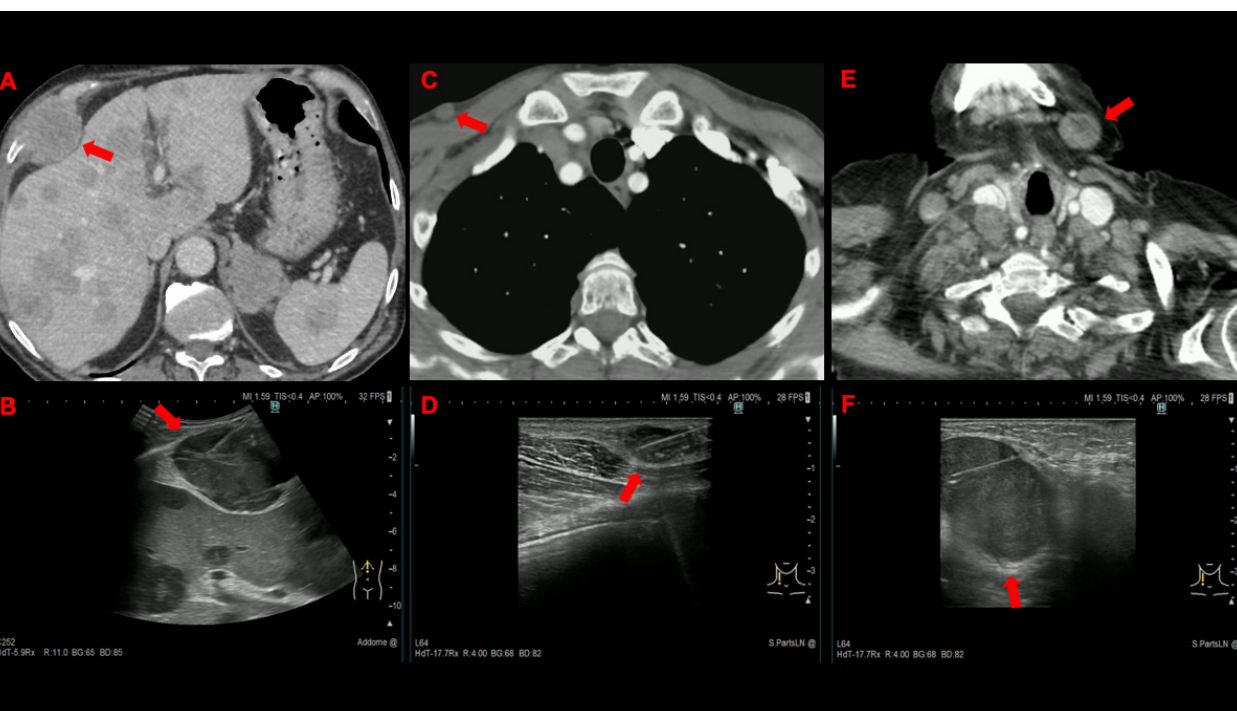
Figure 1. Consort flow diagram of the study. Table 1. Demographics and baseline characteristics of the patients (136) and lesions (144).